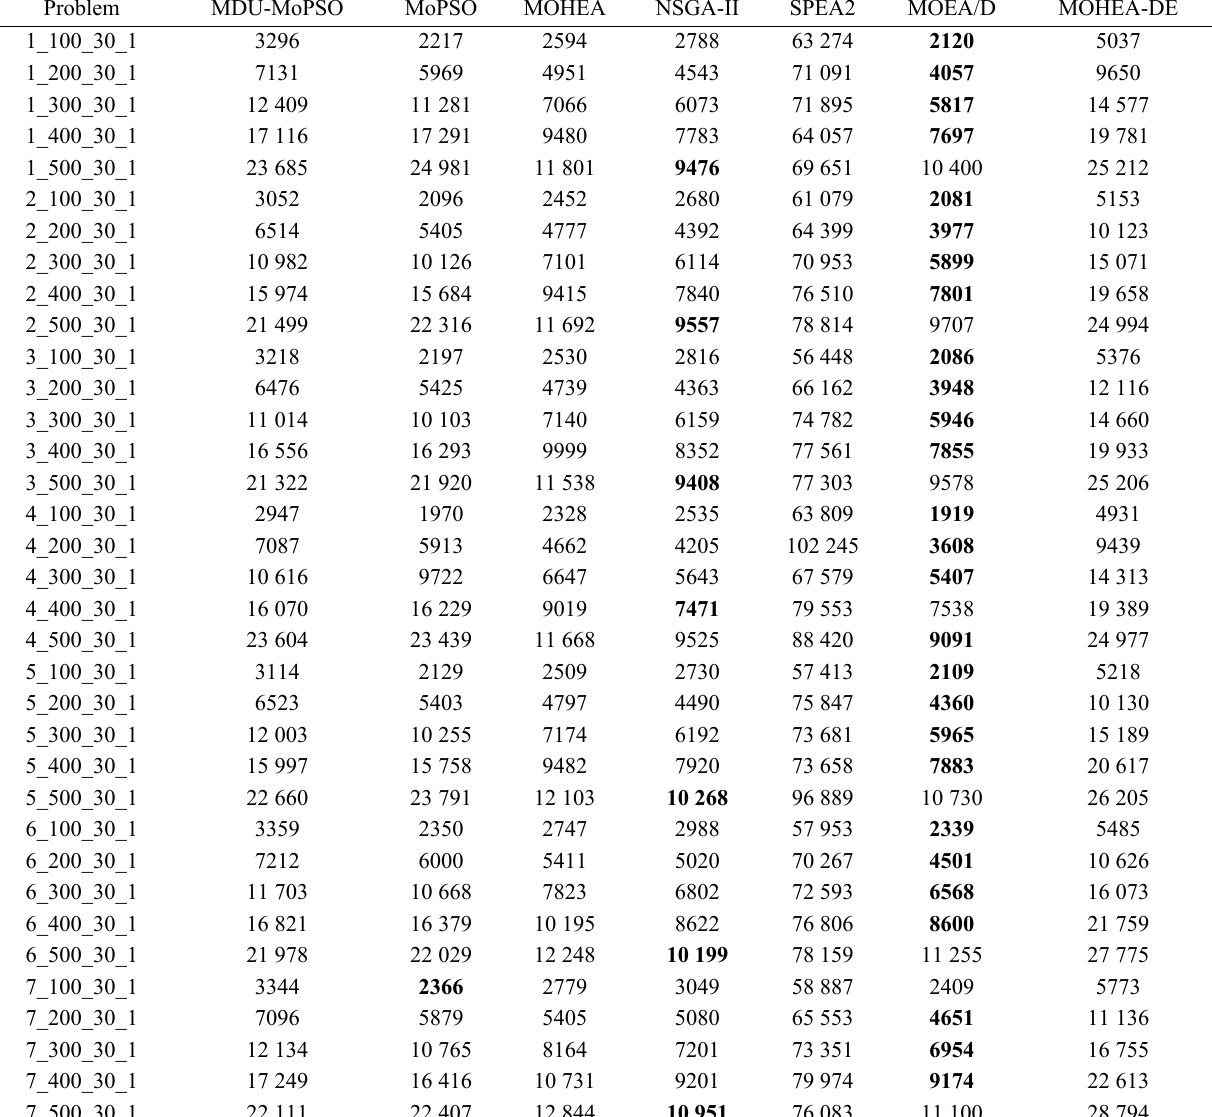
Table 10 Mean of CPU time of different algorithms for the selected problem